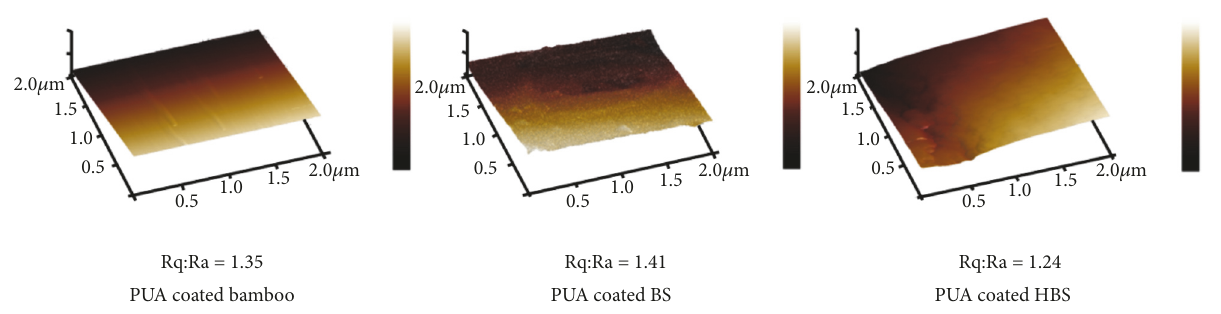
Figure 3: AFM images of PUA coated